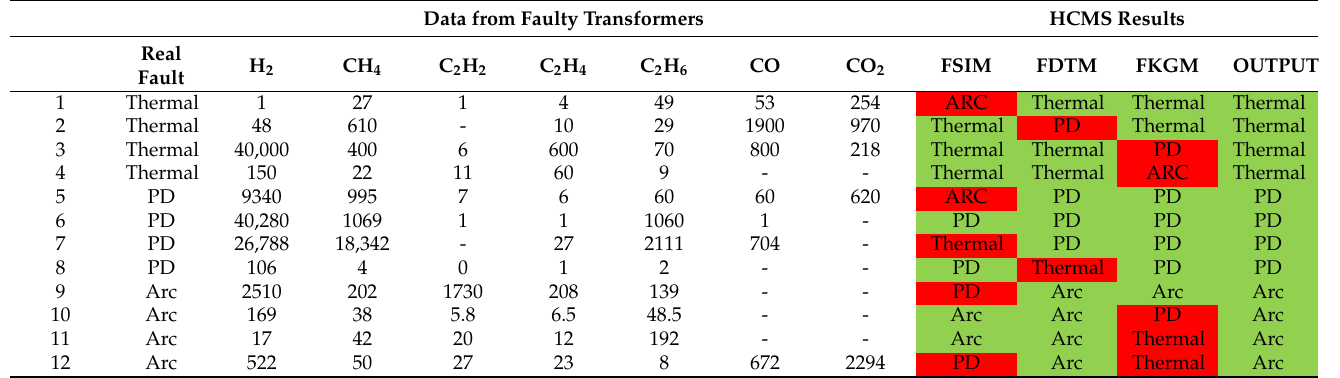
Table 5. Output examples of the HCMS with a mathematical approach *.